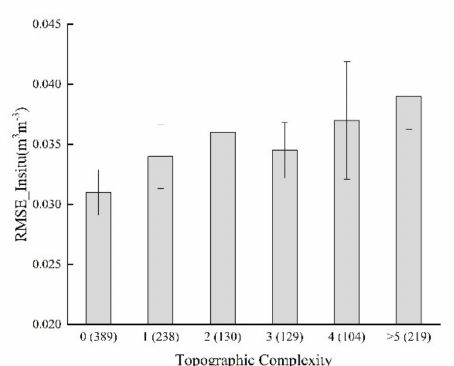
Figure 12. Average RMSE of in situ sites over di ff erent topographic complexity. Zero represents flat terrain, while the large number of topographic complexity represents more complex terrain. Topographic complexity data comes from CCI ancillary data [1]. The numbers in parentheses represent the number of sites in the corresponding topographic complexity. Error bars show 95% confidence intervals obtained from standard